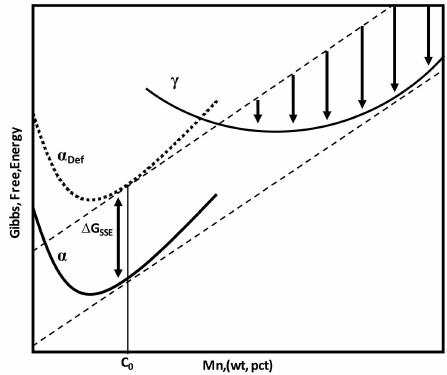
Figure 12. Schematic of Gibbs free energy curves for ferrite, deformed ferrite, and austenite showing driving force for austenite nucleation only from deformed